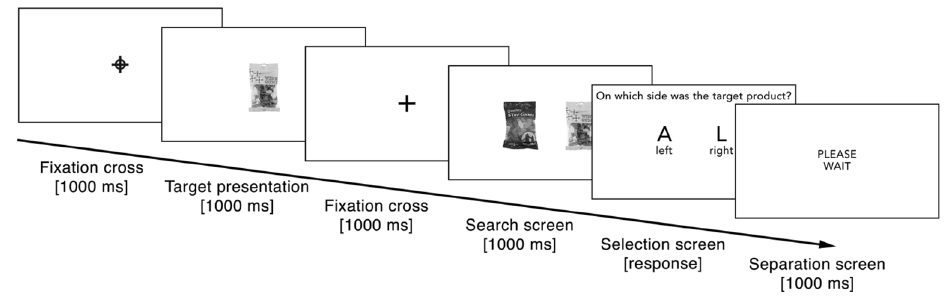
Figure 5. Exposure phase (Experiment 2). Example sequence of one search task during the exposure phase in Experiment